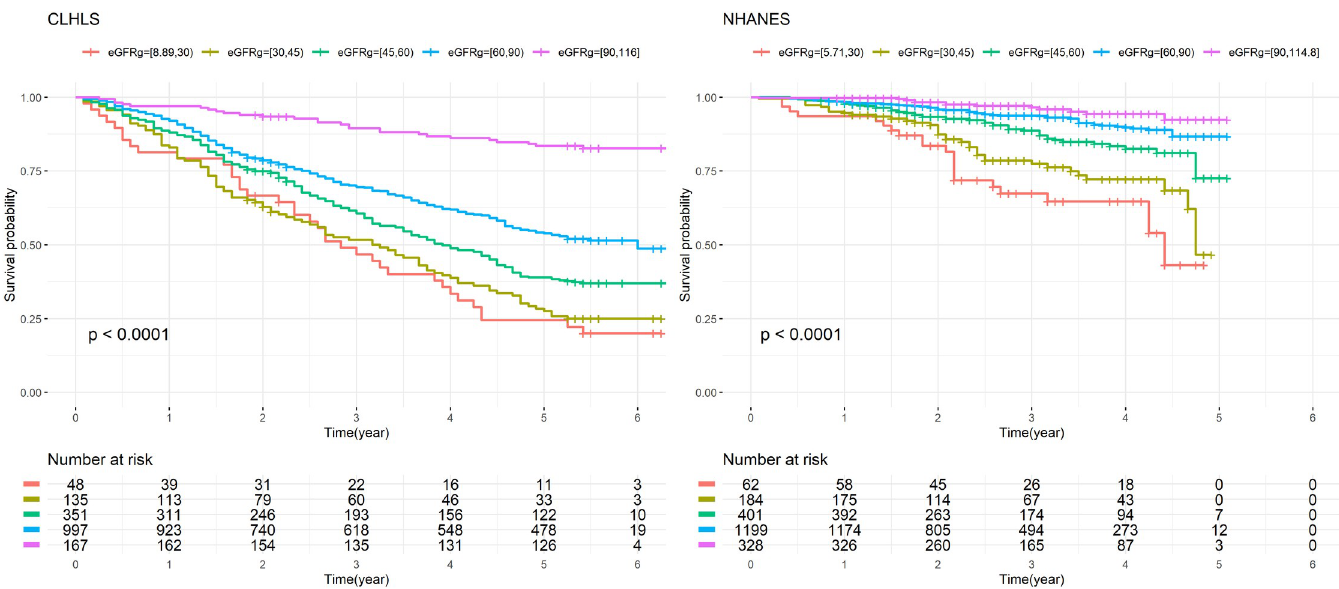
Fig 2. Kaplan-Meier Curve of CKD stage. CLHLS: 2012–2018. NHANES: 2011/2013-2015.